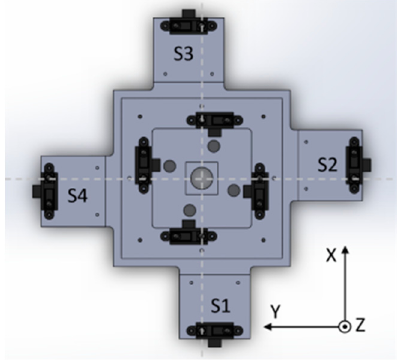
Figure 6. Internal and external range sensors arrangement and compliant wrist’s reference frame.